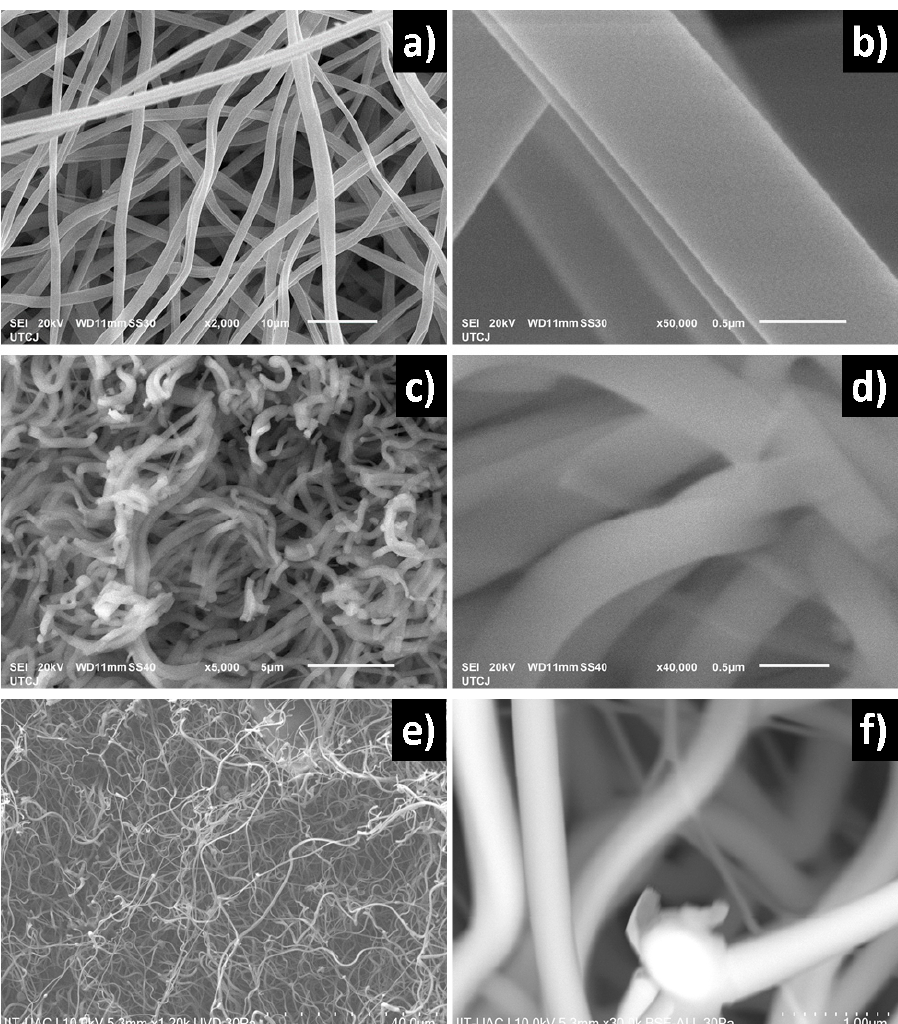
Figure 1. The SEM micrographs of LiNbO 3 /SiO 2 coaxial fibers samples at 100 °C: M003 ( a ) 2000× and ( b ) 50,000×; M03 ( c ) 5000× and ( d ) 40,000×; and M05 ( e ) 1200× and ( f ) 30,000×.